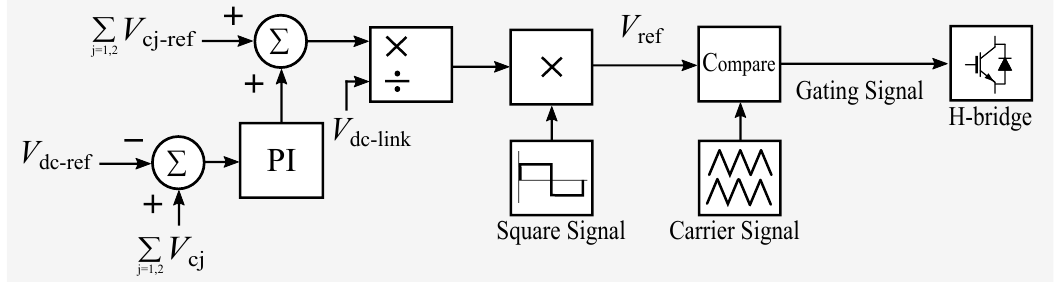
Figure 6. Common-mode voltage regulation.